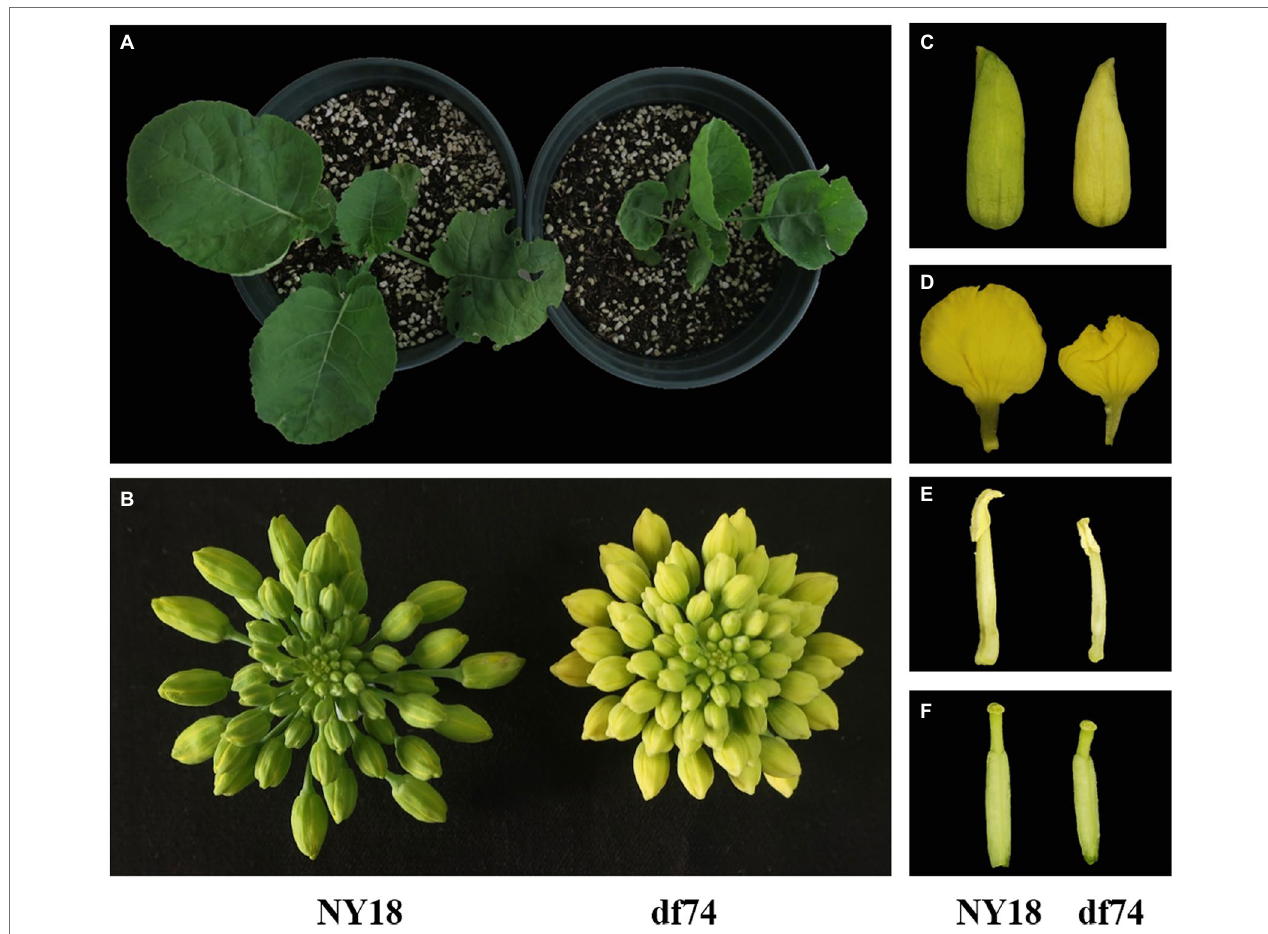
FIGURE 1 | Phenotypic characterization of Ningyou 18 (NY18) and df74. (A) NY18 and df74 at seedling stage; (B) inflorescence of NY18 and df74; (C–F) sepal, petal, stamen, and carpel of NY18 and df74.